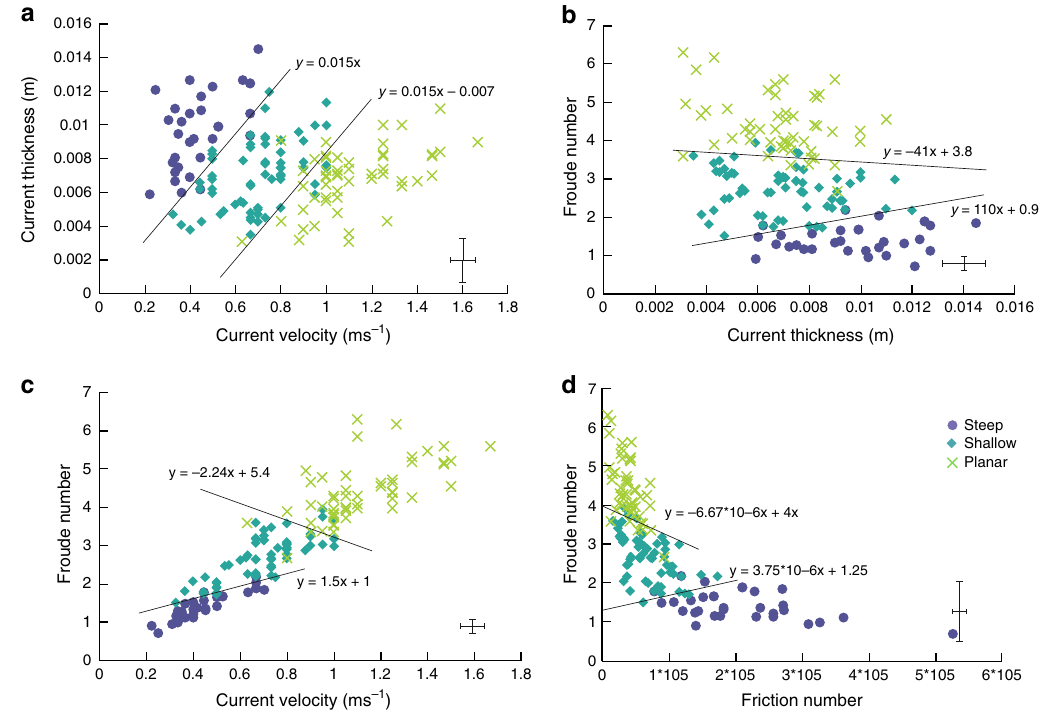
Fig. 4 Phase diagrams showing the current conditions which control backset bedform formation, with plausible phase boundaries. a Velocity vs. thickness. b Thickness vs. Froude number. c Velocity vs. Froude number. d Friction number vs. Froude number. Representative ( n = 20) error bars are located in the bottom right of each image (±2